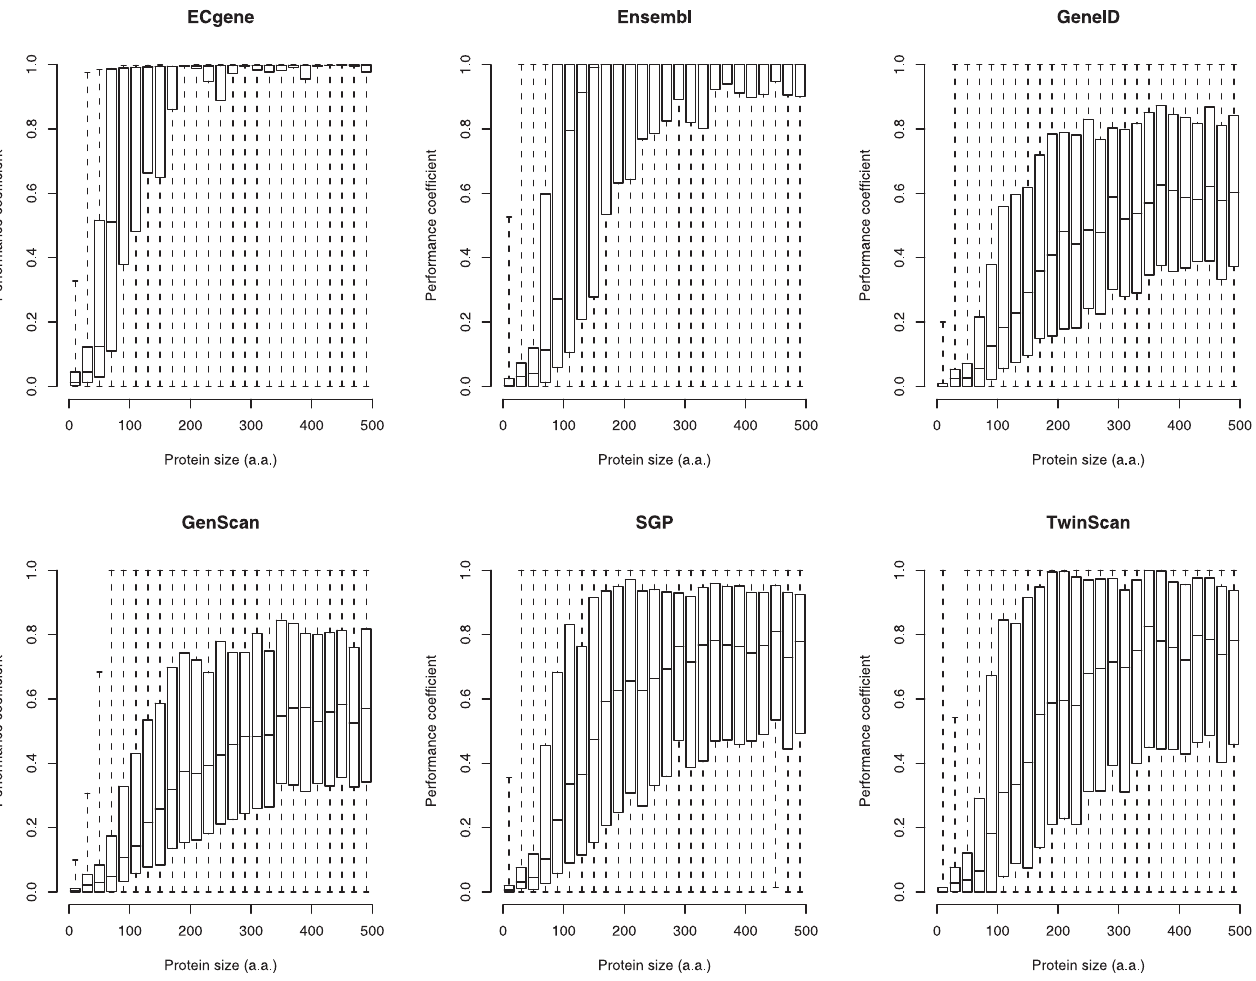
Figure 4. Overlap of FANTOM CRITICA Predictions with Genome-Based Gene Predictions Made by Six Methods Only the 16,900 maximal-length isoforms of the FANTOM CRITICA predictions were considered; these were compared to each genome-based method in turn as follows. Each CRITICA prediction was compared to the genome-based gene prediction that overlapped it by the greatest number of nucleotides, and the degree of overlap was quantified using the performance coefficient: the number of nucleotides in the intersection of the two predictions divided by the number of nucleotides in the union of the predictions [45]. These are box-and-whisker plots: the centre lines indicate the medians, the top and bottom of the boxes indicate the first and third quartiles, and the whiskers extend to the most extreme data points. DOI: 10.1371/journal.pgen.0020052.g004